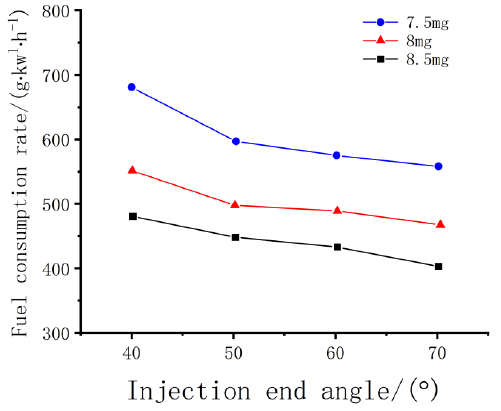
Figure 38. Effect of the injection parameters on fuel consumption.